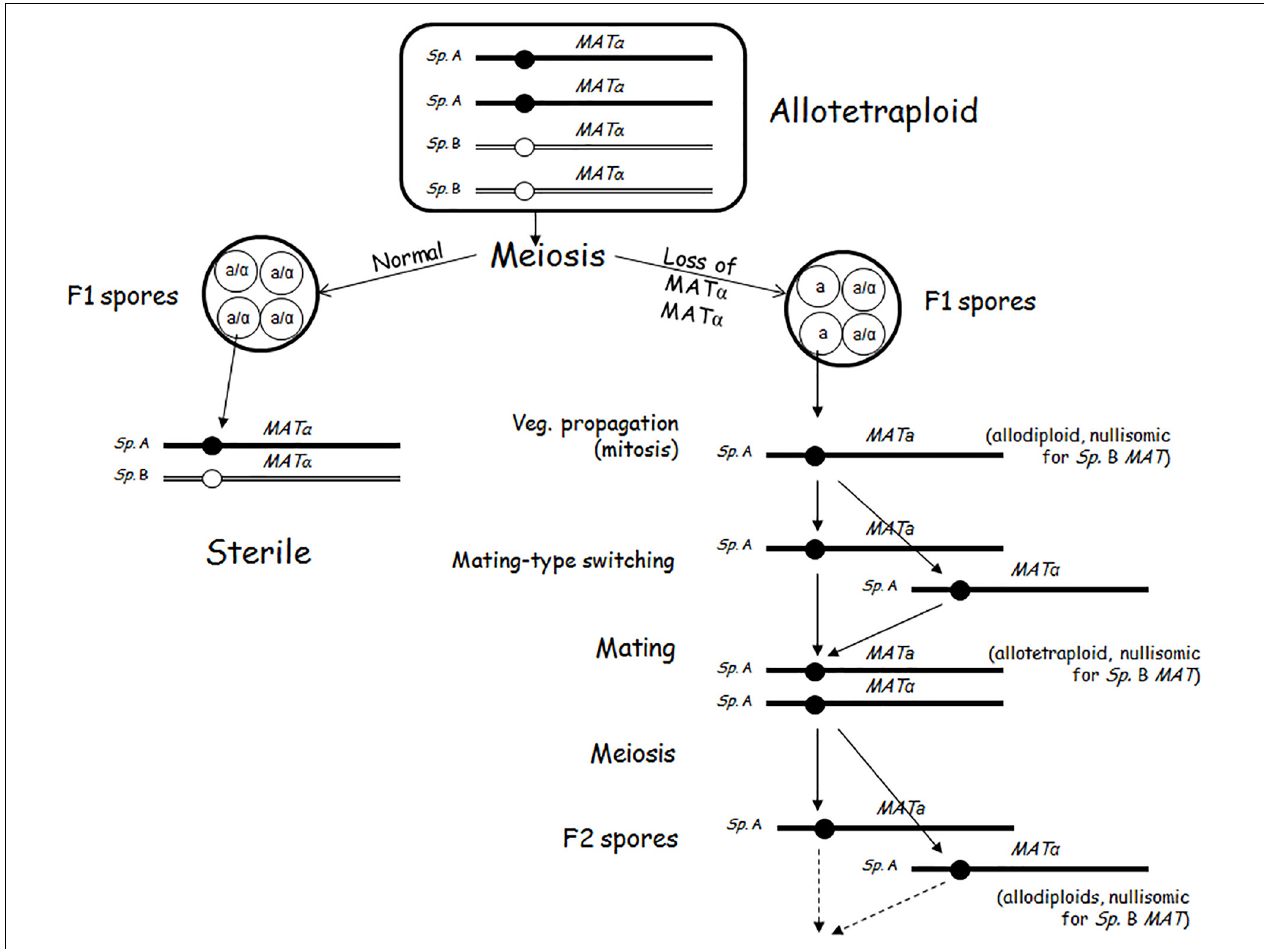
FIGURE 2 | Breakdown of the sterility barrier by malsegregation of the MAT -carrying chromosomes of one subgenome in allotetraploid